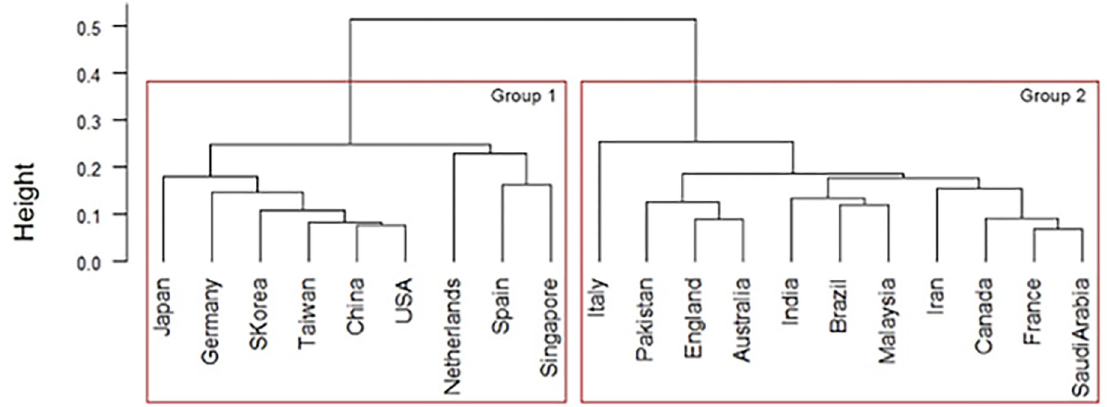
Fig 16. Similarity dendrogram by country: Links between author research areas in the top 20 countries for internet of things. Note . Distance: hclust ( � , “ward.D2”).